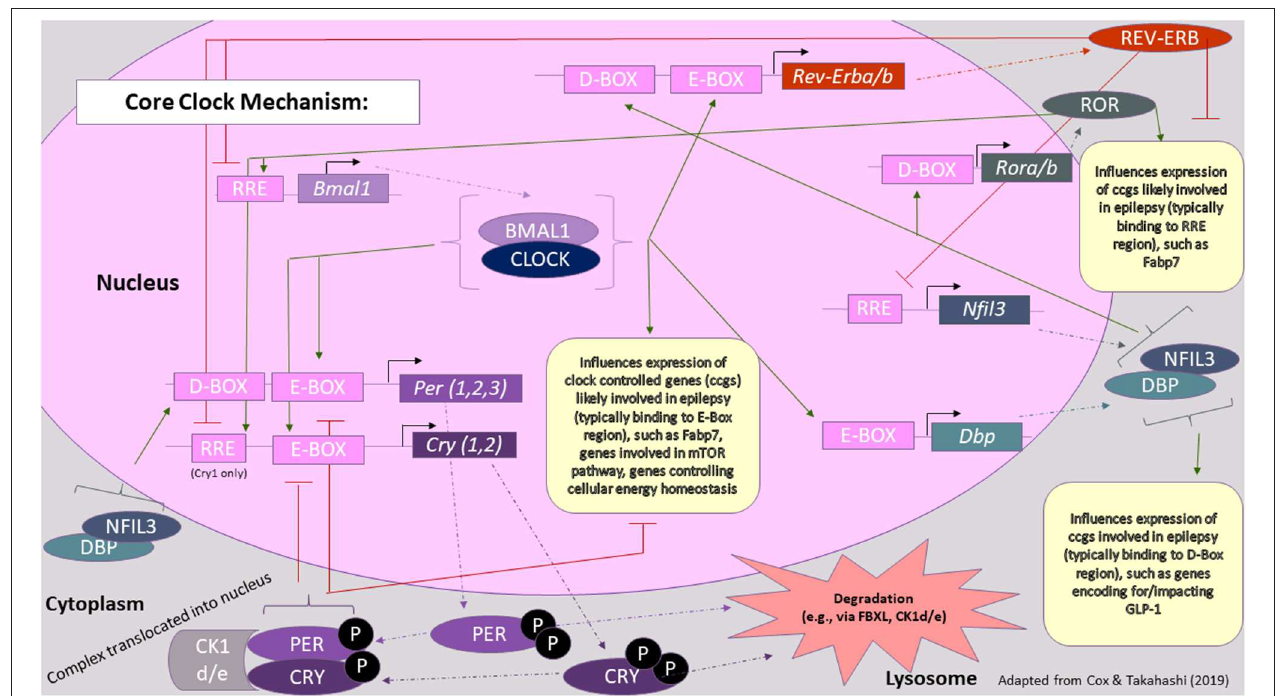
FIGURE 2 | Core clock mechanism in the context of epilepsy. The core clock mechanism consists of three main feedback loops, which are thought to involve PER/CRY, REV-ERB/ROR, and DBP/NFIL3, respectively. Key proteins involved in these loops, whose levels fluctuate over the course of the day, are thought to also influence the expression of genes involved in seizure susceptibility or epileptic processes. Green arrows represent transcriptional activation, whereas red lines represent transcriptional repression. Rectangles represent genes and other DNA sequences of note, whereas ovals represent proteins. For a more comprehensive review on the processes underlying the molecular clock, please refer to (59) [Figure modified from